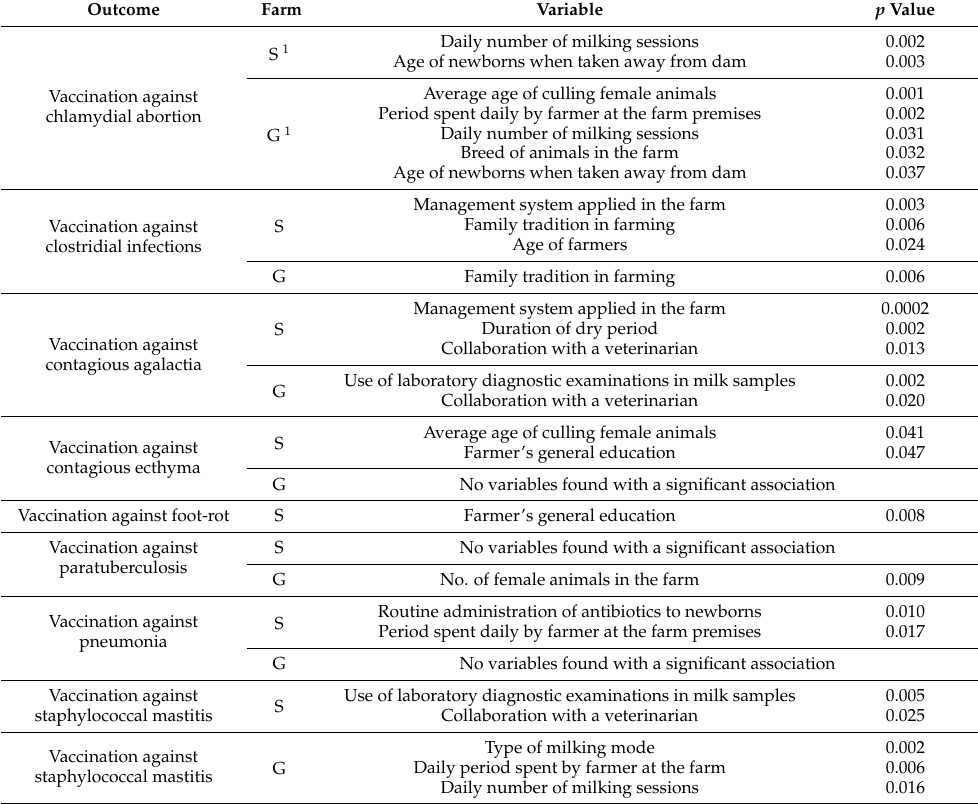
Table 4. Summary of multivariable analyses for outcomes regarding optional vaccinations in small ruminant farms in Greece. Outcome